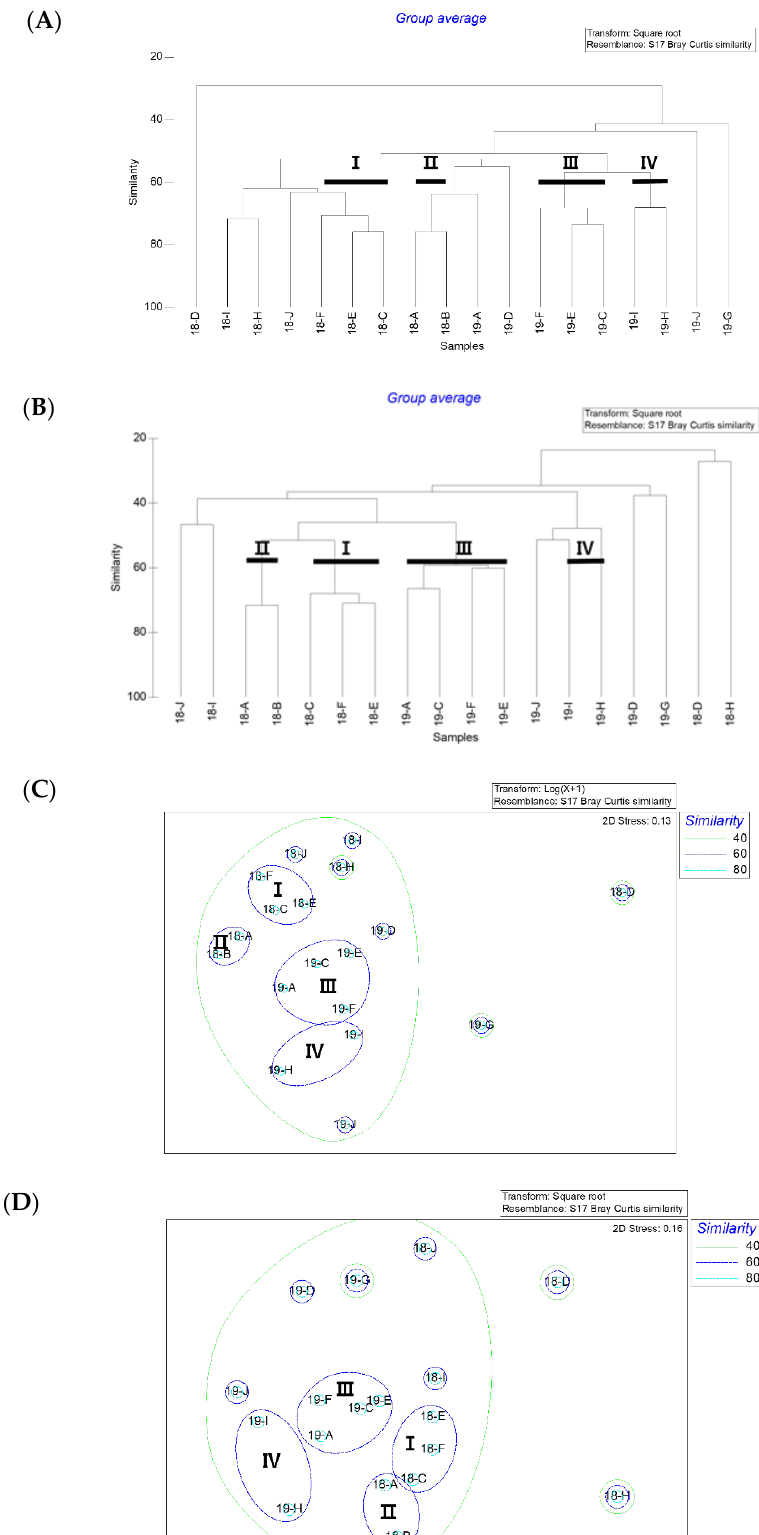
Figure 4. Bray-Curtis similarity-based Cluster at the operational taxonomic Unit (OTU) level illus- trating groups (( A ): Microbial community, ( B ): Phytoplankton community) and non-metric multi- dimensional scaling (( C ): Microbial community, ( D ): phytoplankton community) in C. polykrikoides bloomed water